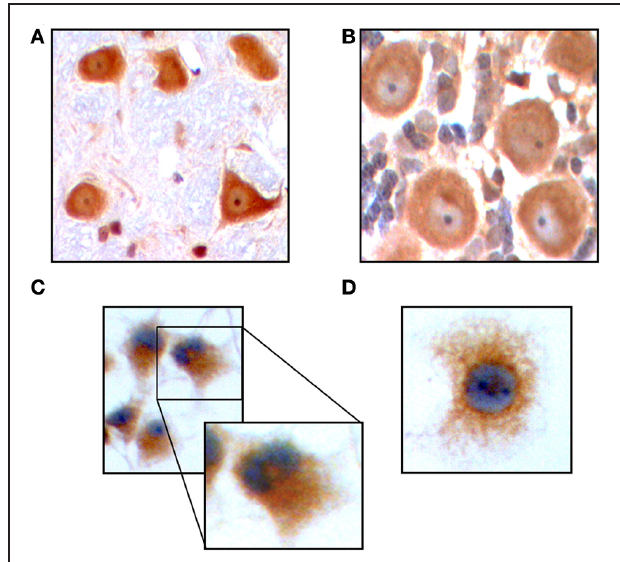
FIGURE 1 | Immunohistochemistry in Purkinje cells of the rat cerebellum demonstrates expression of AR. Original magnification 200 X (A). AR expression in neurons of the rat brain stem. Original magnification 200 X (B). Immunocytochemistry for AR on PC12 in culture. Details of receptor expression are shown in the inset. Original magnification 200 X (C). AR expression in PC12 cells. Original magnification 400 X (D)